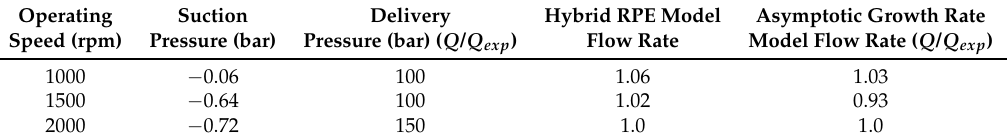
Table 3. Mean flow rate comparison between the Hybrid Rayleigh–Plesset equation model and the Asymptotic Growth Rate model.